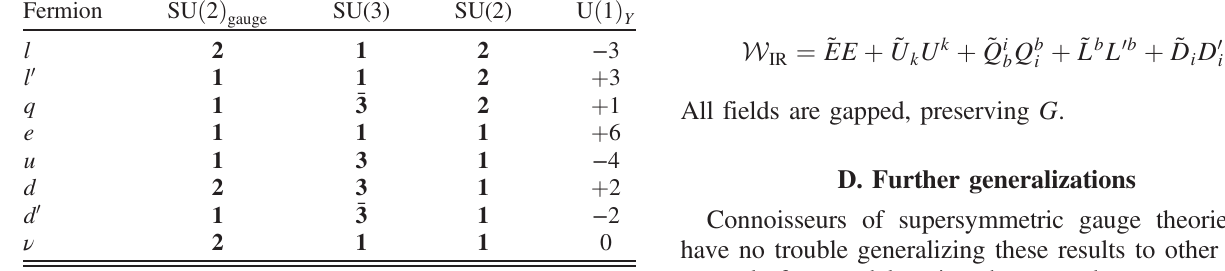
TABLE III. Quantum numbers of the extended standard model. Fermion